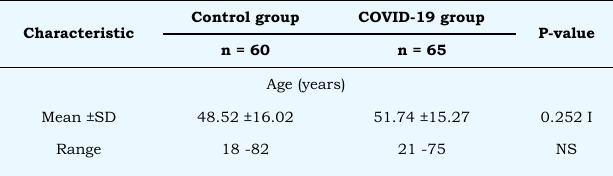
Table 1 Comparison of demographic characteristics between patients with COVID-19 and healthy controlled persons